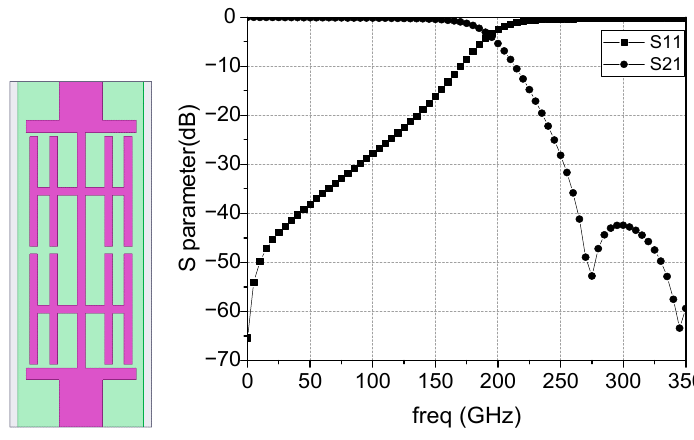
Figure 4. The structure of the low-pass filter and its S-parameter.